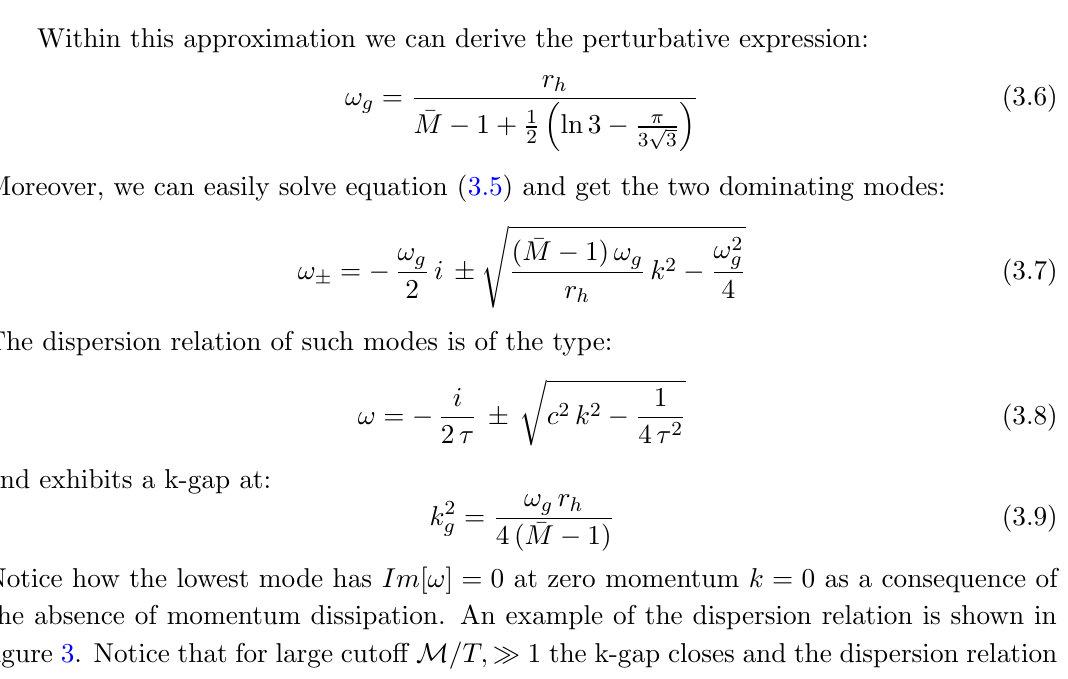
Figure 3 . The dispersion relation (3.7) for M =r h = 5 ; 8 ; 100 (from green to blue) in terms of the dimensionless frequency and momentum (cid:22) ! = !=r h , (cid:22) k = k=r h . At large cuto(cid:11) the k -gap closes and the dispersion relation becomes (cid:22) ! = (cid:22) k